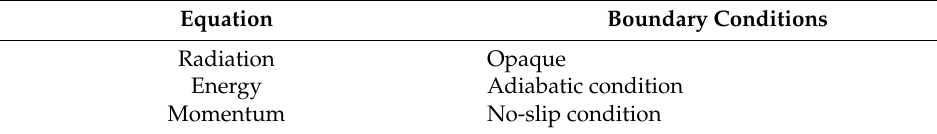
Table A7. Outside soil surface, other buildings